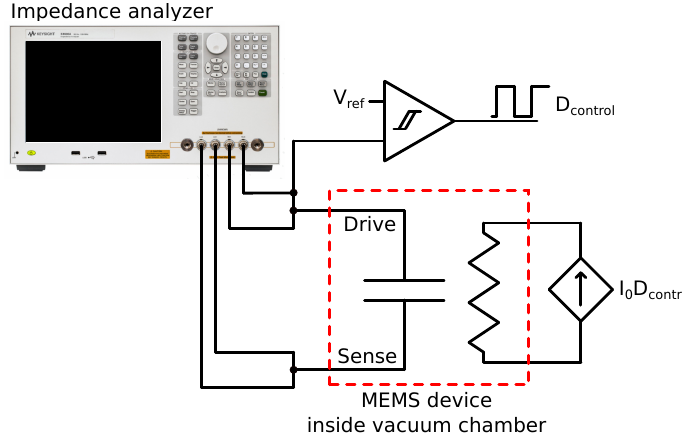
Figure 6. Schematic of the setup used to perform magnetic field sensitivity measurements. The impedance analyser performs 4-wire measurements. The analyser driving output is sampled and the signal sign D control is detected and used to drive an adjustable current source. As a result, the controlled current source output I O D control is an ac current without dc